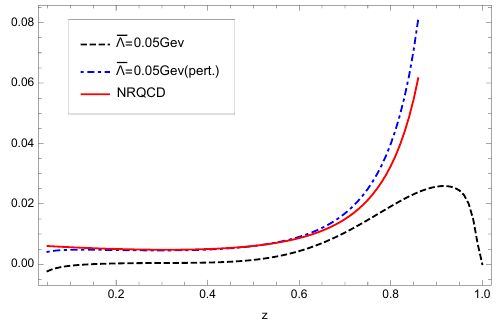
Figure 8 . Comparison of the gluon FFs obtained in SGF and NRQCD, where “pert.” means expanding D ¯Λ=0 . 05GeV to NLO in α s and replacing M H by 2 m Q g → H